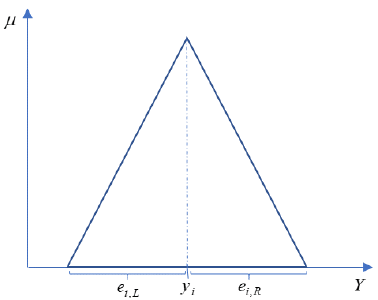
Figure 2. The triangular fuzzy number of 𝑌̃ .